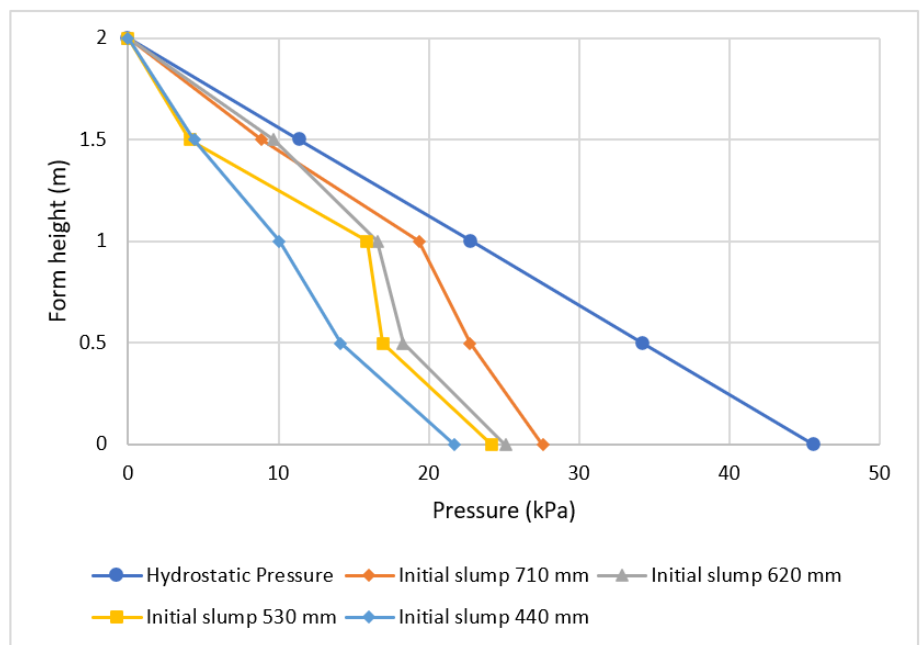
Figure 5. Effect of initial slump flow on pressure.